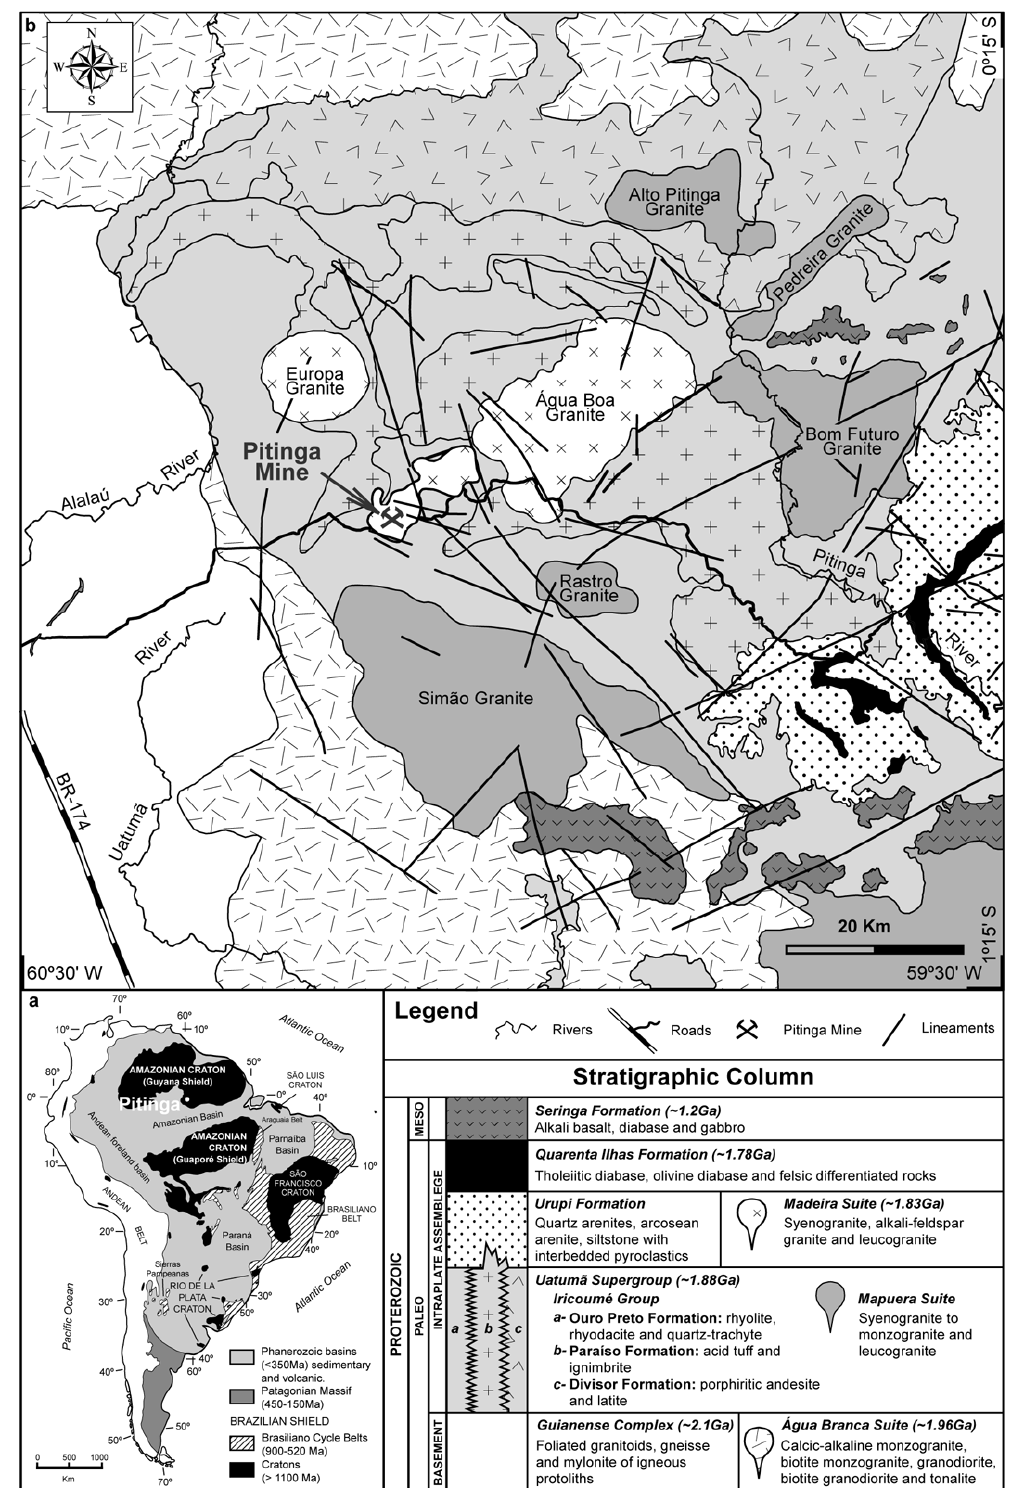
Fig. 1 – Location (a) and geological map (b) of Pitinga Mining District. (modified from (a) Hartmann and Delgado 2001 and (b) Ferron et al.